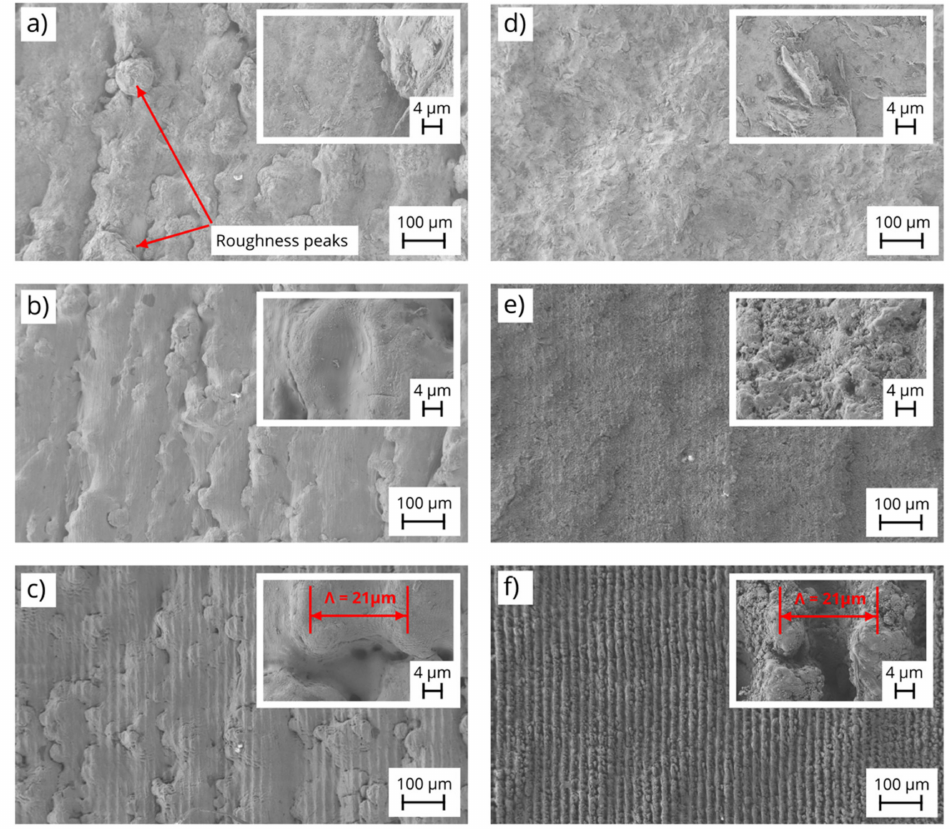
Figure 2. SEM images of initial ( a , d ) and DLIP-treated samples using pulse overlaps of 50% ( b , e ) and 98% ( c , f ) and a set laser fluence of 3.2 J/cm 2 for AM specimens made of Ti64 ( a – c ) and Scalmalloy ® ( d – f